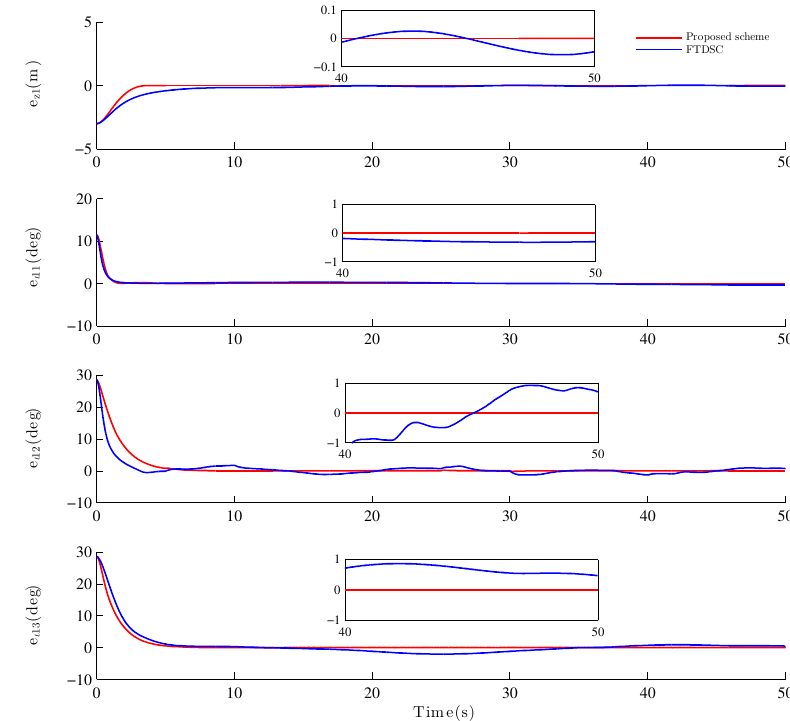
Figure 3. Time response of trajectory/attitude tracking